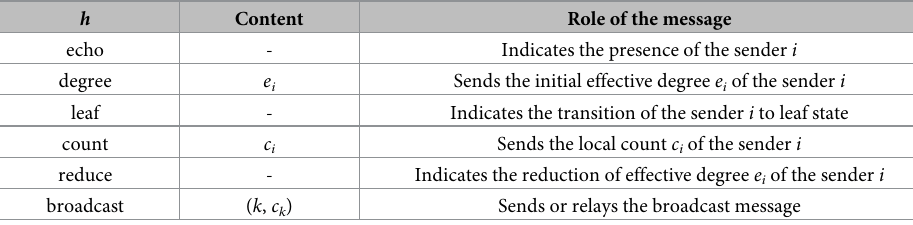
Table 1. The different types of messages m i , h used in the AnB